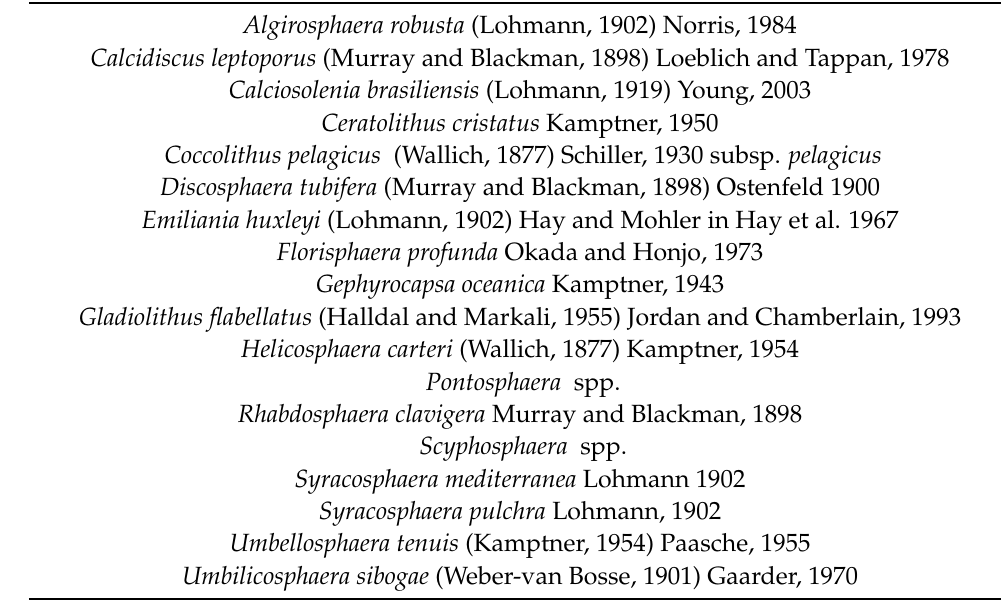
Table 2. List of coccolithophore species recorded in the studied sediment trap